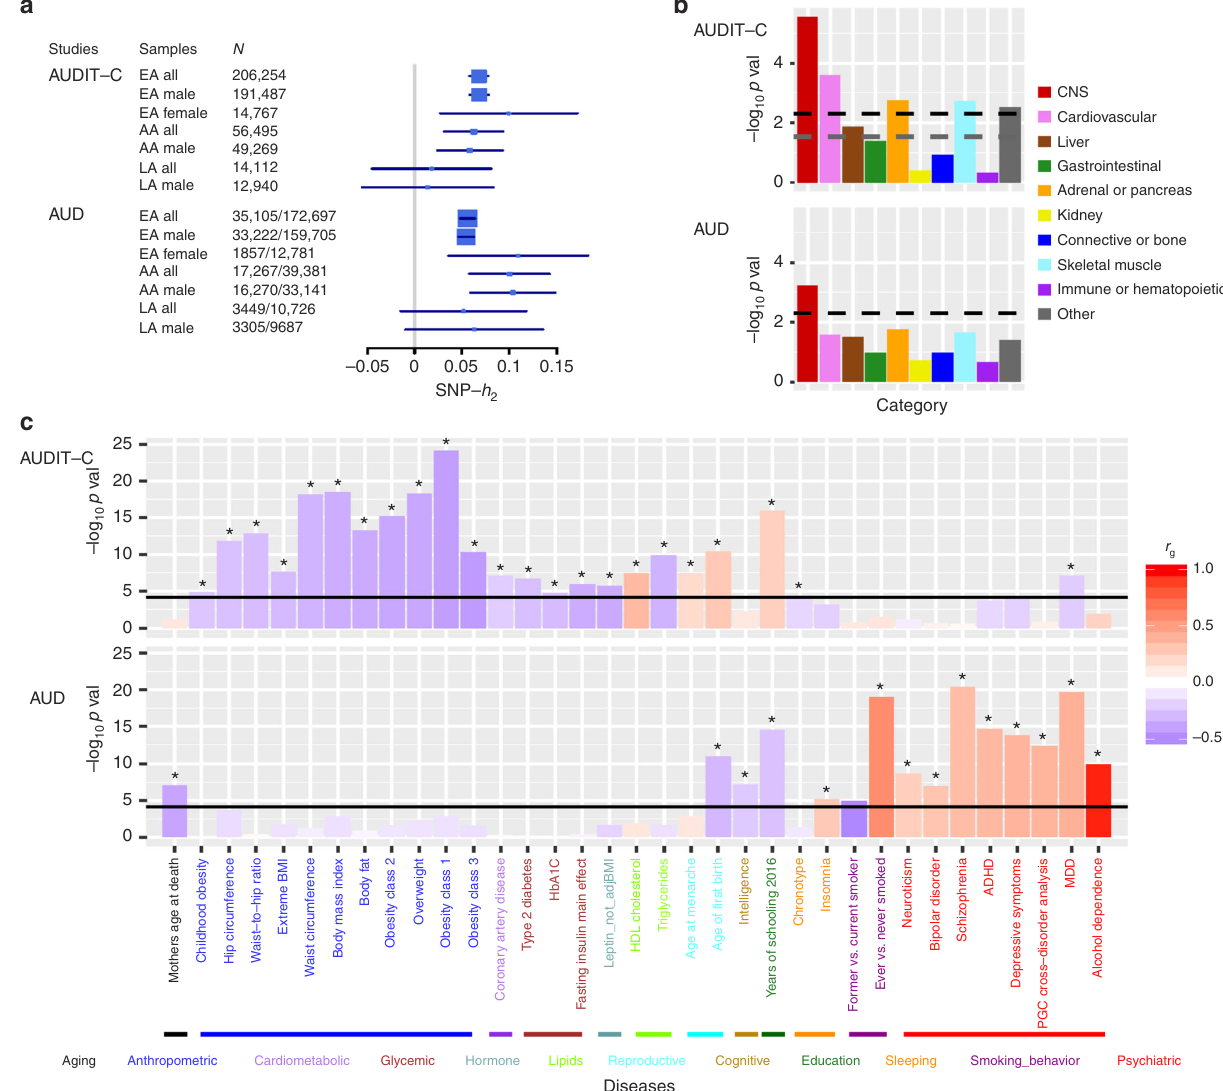
Fig. 2 Heritability estimate, partitioning enrichments of heritability, and genetic correlation analyses using LD score regression. a SNP-based heritability for AUDIT-C and AUD in the three populations and sex-strati fi ed samples adequate in size for the analysis. b Partitioned heritability enrichment of cell type groups for AUDIT-C and AUD. Ten cell types tested were corrected for multiple testing. The black dashed line is the cutoff for Bonferroni-corrected signi fi cance. The gray dashed line is the cutoff for FDR < 0.05. c Genetic correlations with other traits. Data from 714 publicly available datasets (221 published and 493 unpublished from UK Biobank) were tested and corrected for multiple comparisons. The signi fi cantly correlated traits presented are for published data. Black lines are the cutoff for Bonferroni-corrected signi fi cance, with asterisks showing traits signi fi cant after correction. The traits are grouped into different categories and sorted by the genetic correlations with AUDIT-C (upper panel) or AUD (lower panel). CNS central nervous system, ADHD attention de fi cit hyperactivity disorder, MDD major depressive disorder NATURE COMMUNICATIONS| (2019) 10:1499 |https://doi.org/10.1038/s41467-019-09480-8|www.nature.com/naturecommunications